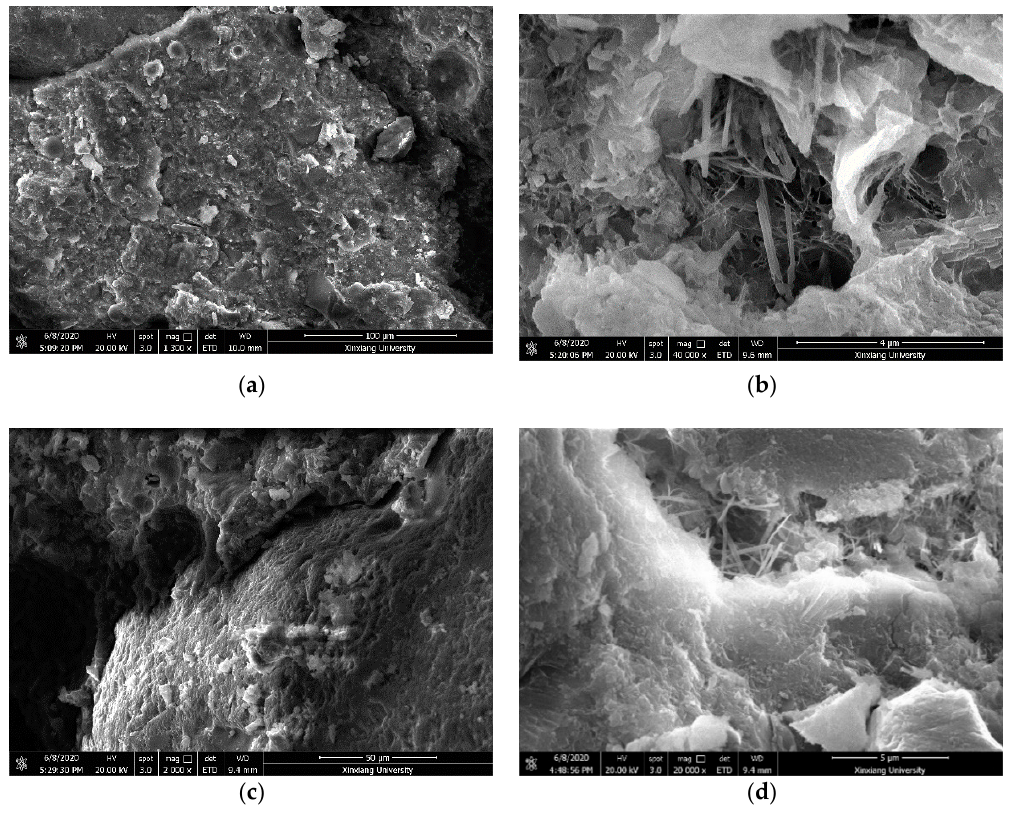
Figure 1. Microstructure of ( a ) control, ( b ) NSC-0.5, ( c ) MRC-5, ( d ) MR5N3.